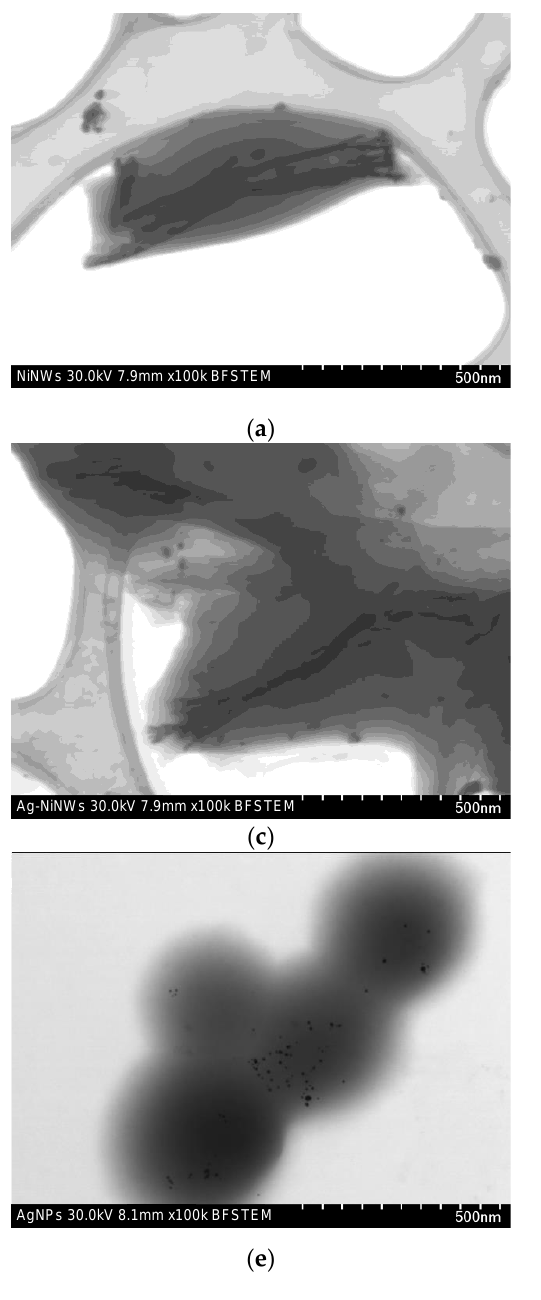
Figure 4. Bright-field ( right ) and dark-field ( left ) micrographs of ( a , b ) gelatin-covered NiNWs, ( c , d ) AgNP/gelatin-coated NiNWs, and ( e , f ) AgNP/gelatin nanoparticles decorated with silver nano par- ticles to demonstrate the capacity to easily embed nanostructured components inside a gelatin ma- trix.